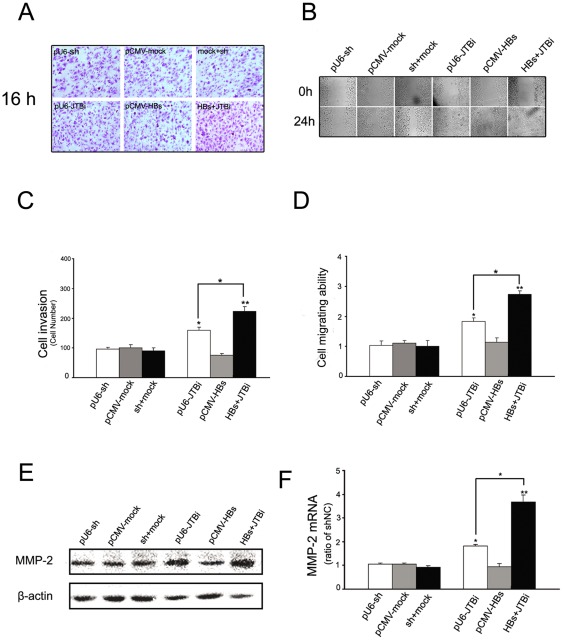
Transient knock-down of JTB promotes migration and invasion in the HCC cells expressing high levels of JTB.(A) Images and graphs (C, *P<0.05) from invasion assay at 16 h; (B) Images and graphs (D, *P<0.05) from migration assay the migrating ability of control cells at 24 h was considered as 1 in (D); The MMP-2 protein expression was detected using western blot analysis (E), and the mRNA expression was quantified using qRT-PCR (F).